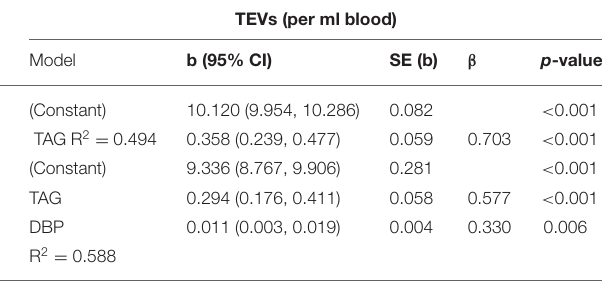
TABLE 3 | Independent predictors of TEV numbers determined by stepwise regression. TEVs (per ml